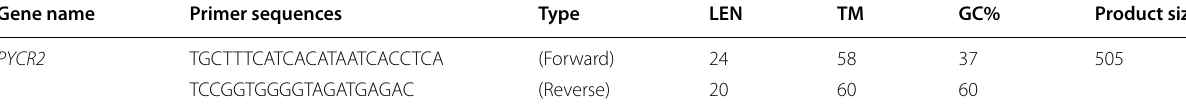
Table 1 The primer sequences used for amplification of region containing the PYCR2 variant